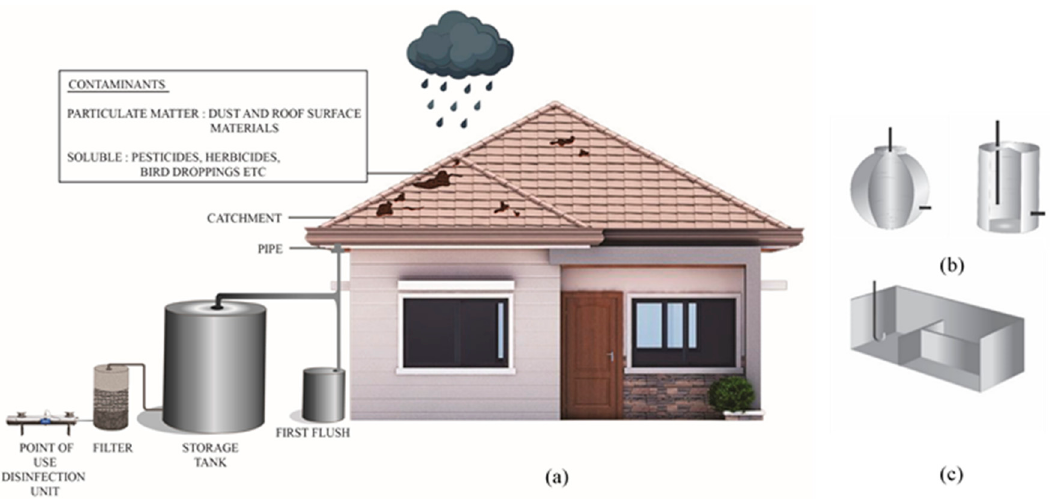
Figure 1. ( a ) Typical rainwater harvesting system (RWH), ( b ) typical inlet / outlet configurations in a storage tank, and ( c ) RWH system with a calmed inlet proposed by reference [3].